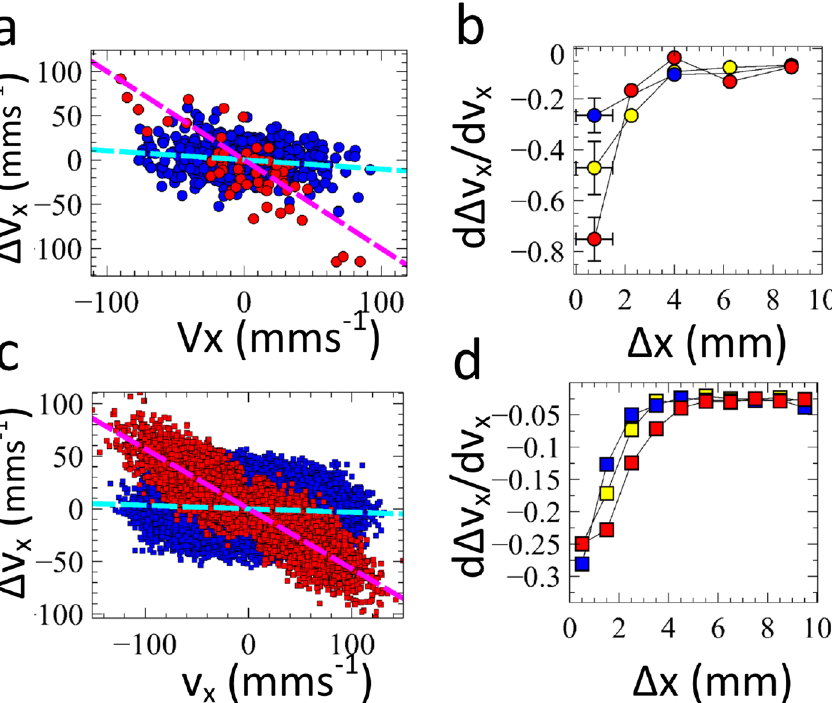
Figure 2. Friction of a bouncing ball. ( a ) Experimental measurement of bouncing ball ( Ŵ = 3.25). The change in velocity at each bounce within 1 mm of the end walls (red) and the centre of the cell (blue). The gradient of the line indicates the frictional impulse. ( b ) The frictional impulse at different distances from the side wall. Ŵ = 2.25 (blue), 2.75 (yellow), 3.25 (red). ( c ) Simulation of a bouncing ball. The change in velocity of particles whose last collision was with the end wall (red) and those whose last collision was with the base (blue). ( d ) The frictional impulse for simulation at different distances from the side wall. Ŵ = 2.25 (blue), 2.75 (yellow), 3.25 (red). (Figure prepared using Veusz https ://veusz .githu